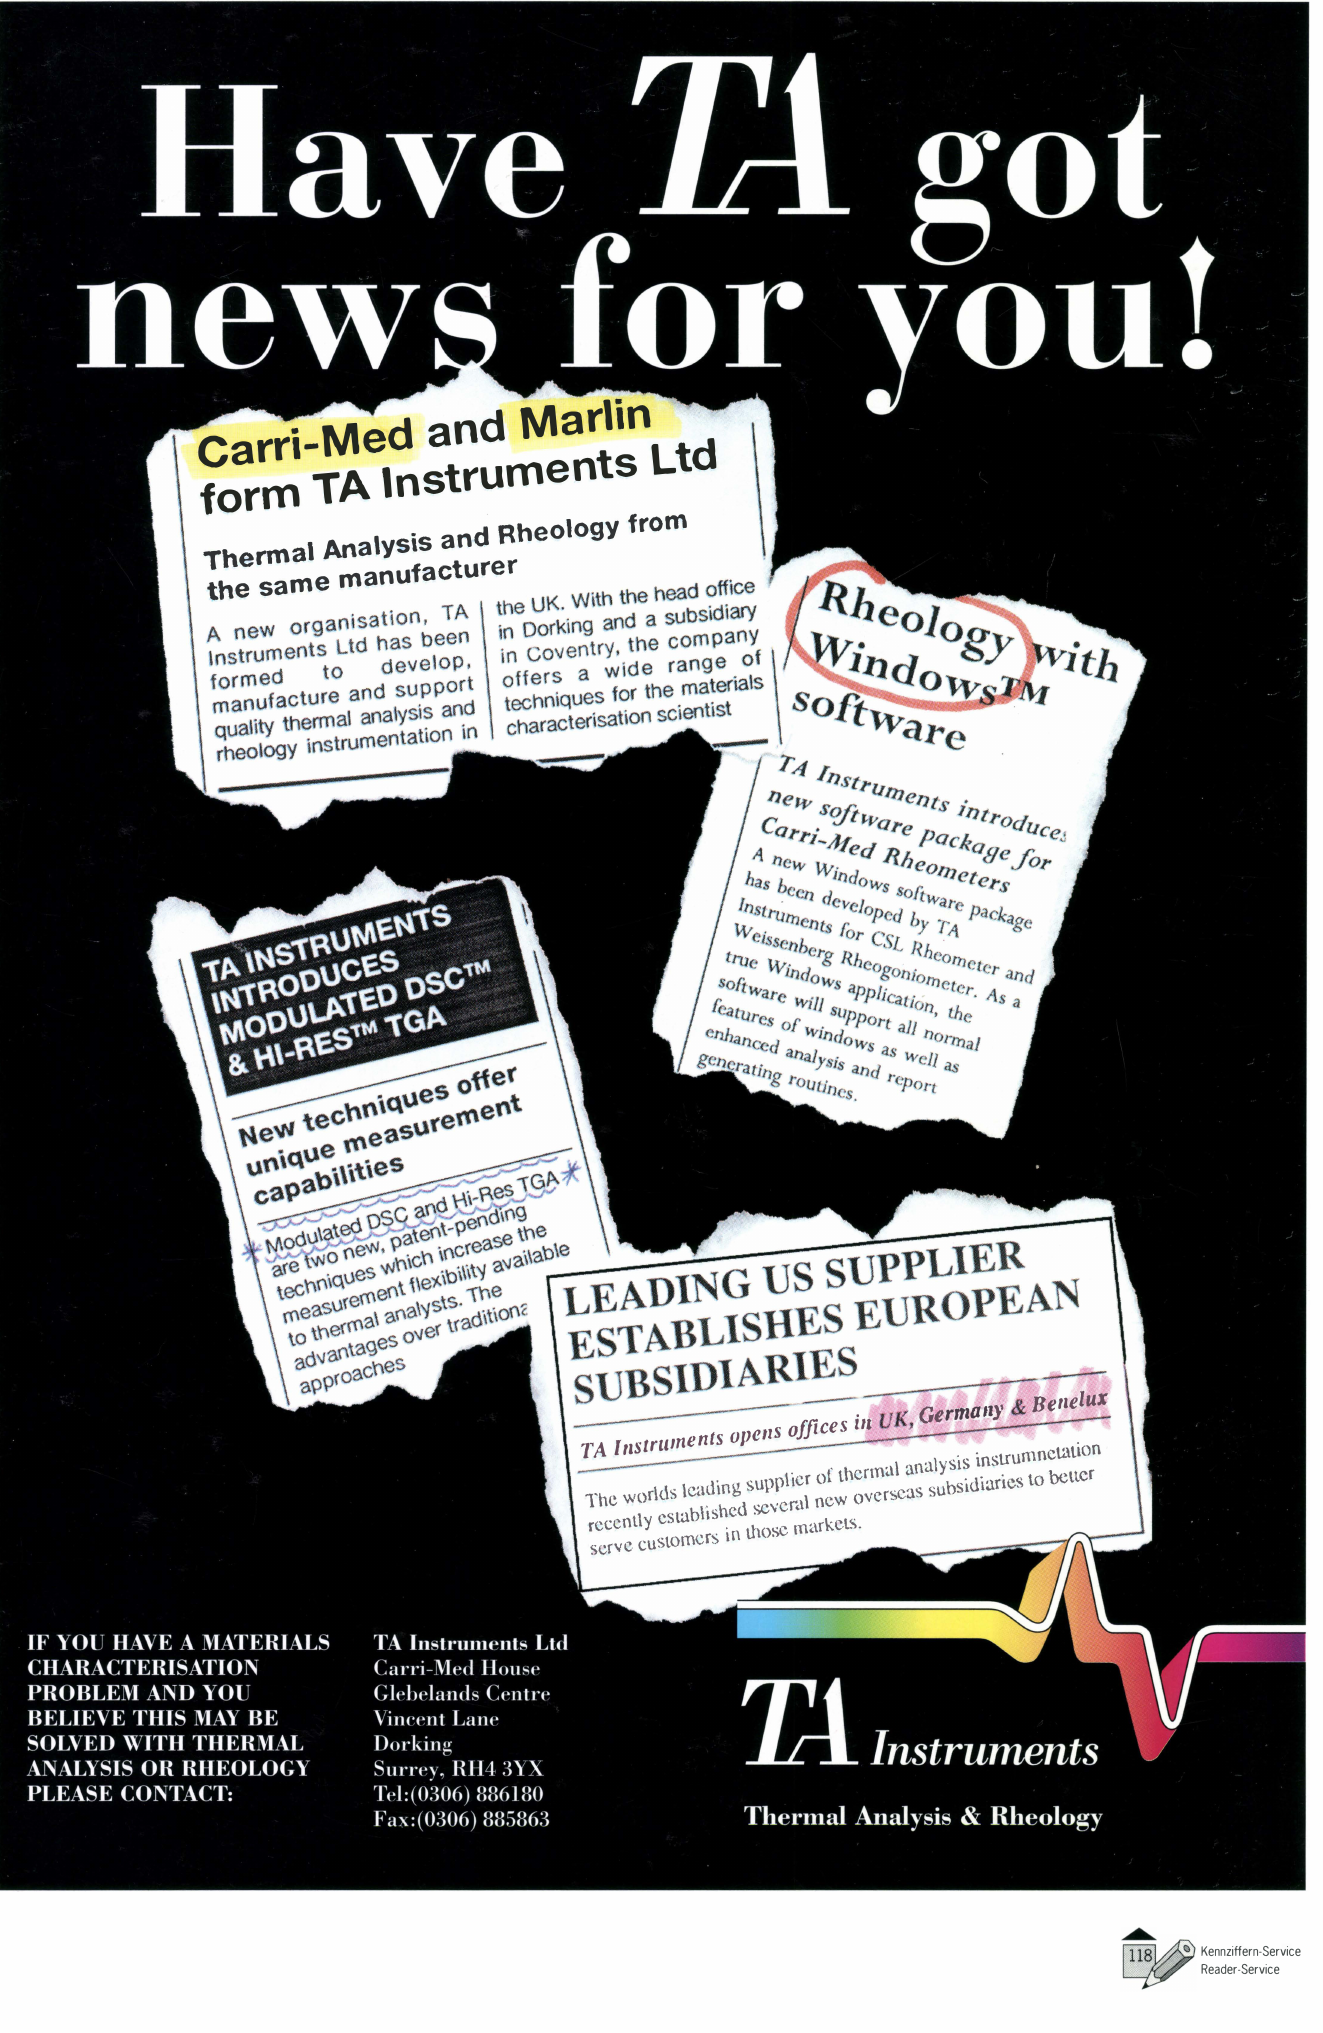
� Kennziffern-Service L.{!:/"'